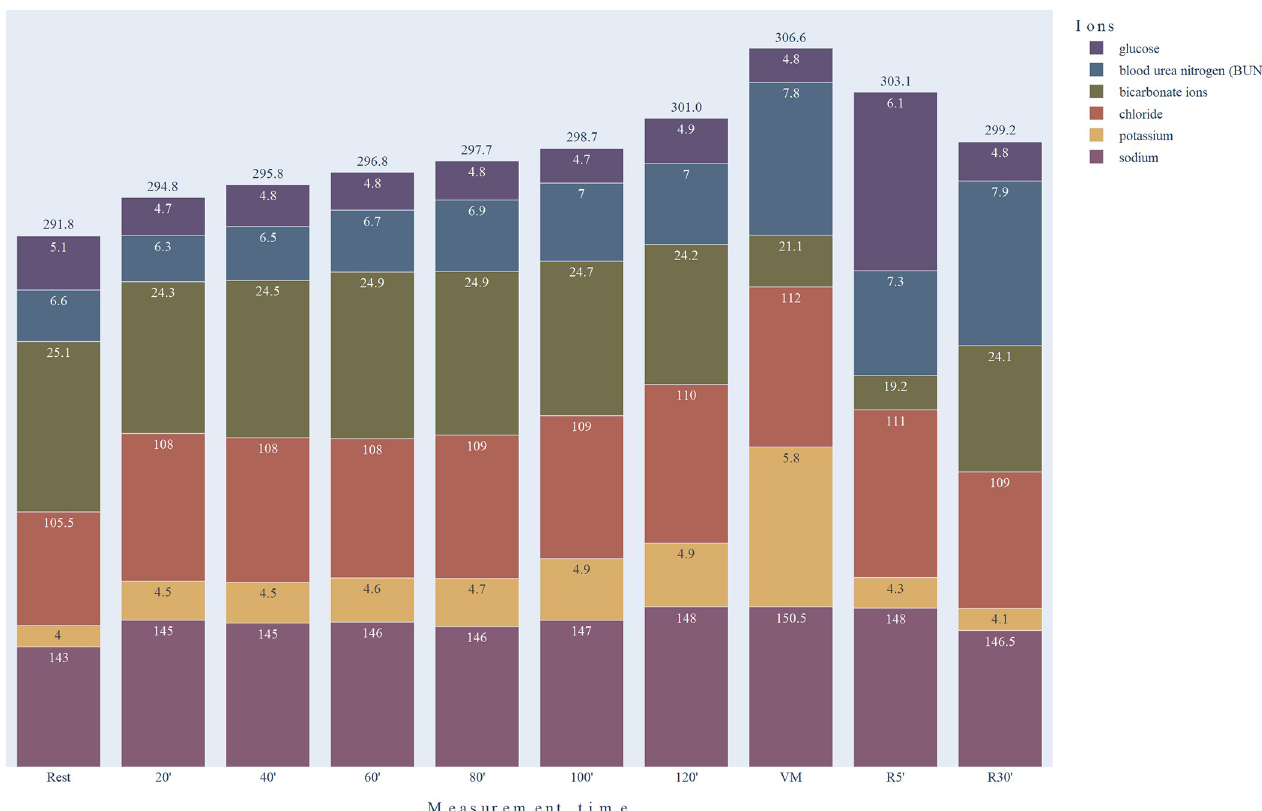
Fig 4. Changes in major blood components influencing plasma osmolality during the long dehydration protocol. Rest: baseline values, sampling time before exercise; 20’, 40’, ... , 120’: sampling times at 20 th , 40 th , ... , 120 th minutes of the exercise, respectively. VM: sampling time at the maximum power after 120 min preload; R5’ and R30’: sampling times at the 5 th and 30 th minutes of the recovery period, respectively. A major part of the osmolality is given by the change of sodium ions. To better represent visually the changes in the other components, we used an exponential magnification of the values, however, the numbers on the graphs show the actual values. The height of the columns and the numbers at the top indicate the changes in osmolality values.